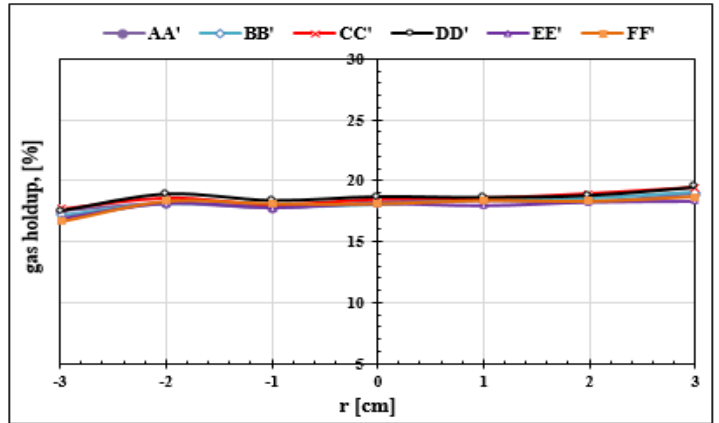
Figure 15. Radial distribution of gas holdup for different traverses.